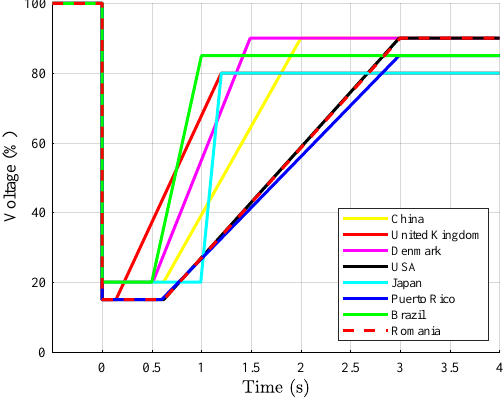
Figure 5. LVRT requirements in various countries.